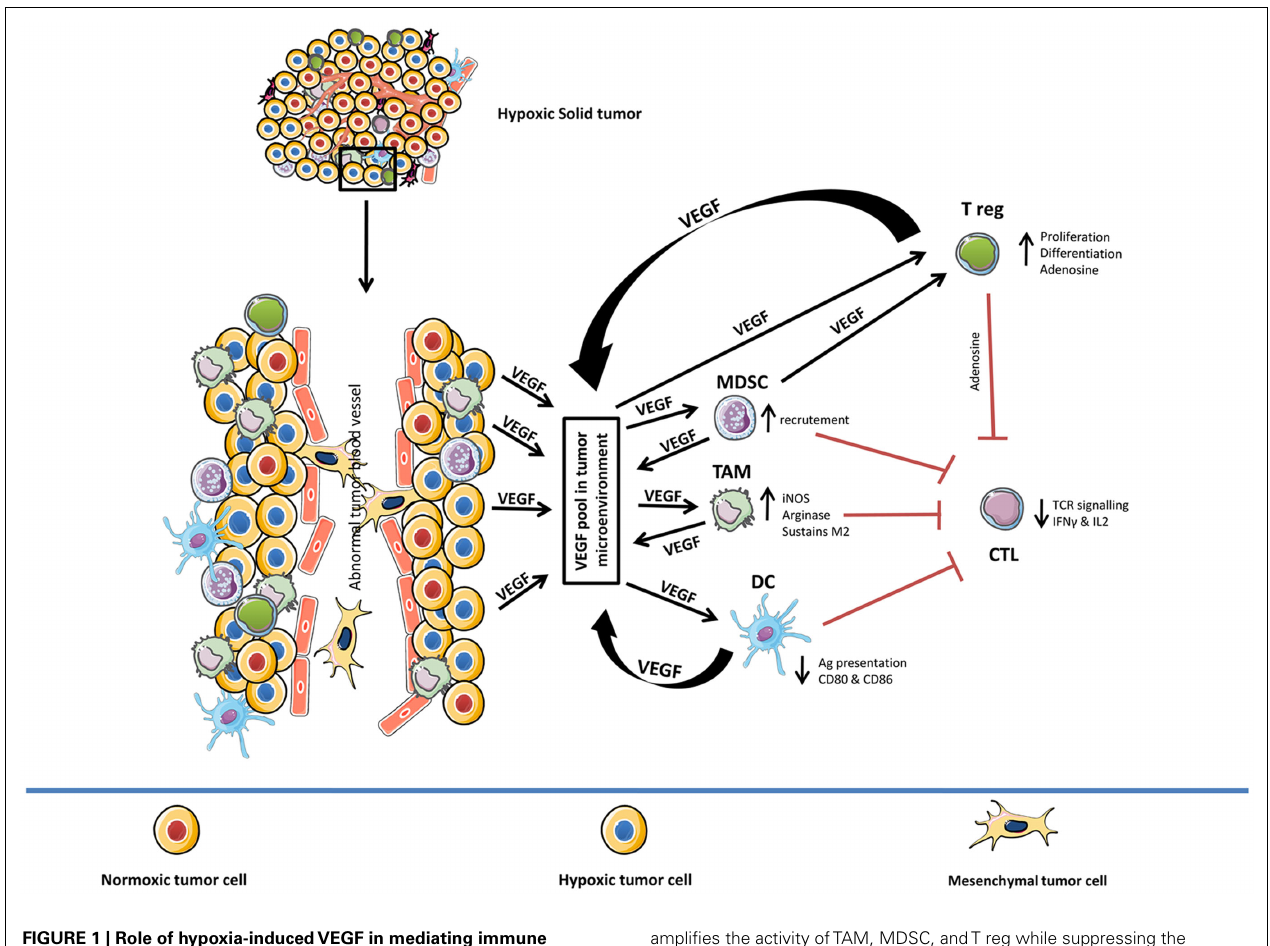
FIGURE 1 | Role of hypoxia-inducedVEGF in mediating immune tolerance. Diverse effects of hypoxia-inducedVEGF on different components of the immune system (TAM, MDSC, DC, CTL, andT reg). In general, hypoxia-inducedVEGF pool in tumor microenvironment (VEGF secreted by hypoxic tumor cells,TAM, MDSC, DC, andT reg)